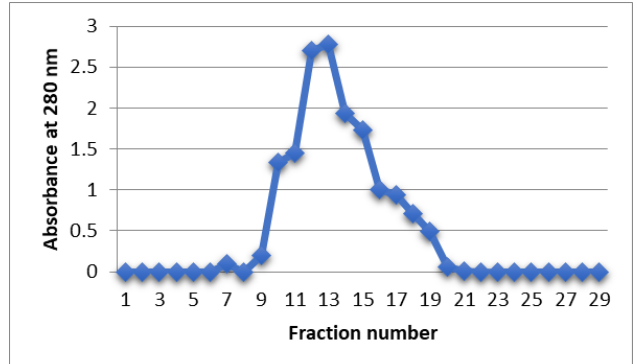
Figure. 2: Purification of streptocin SH3 by gel filtration chromatography using Sephadex G-50 column with dimensions (2x46) cm that equilibrated